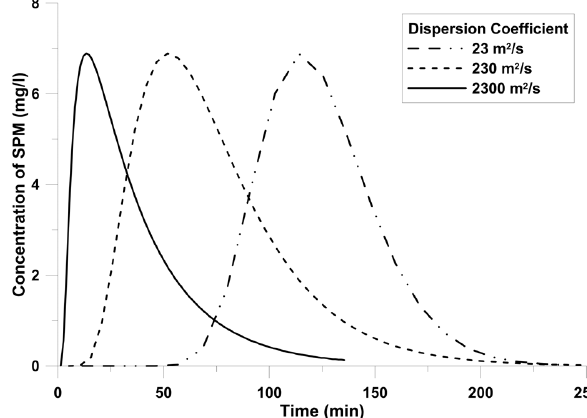
Figure 9. Calculated variation in SPM concentration with time for the first event in the Agnesberg landslide using different values on the dispersion coefficient.